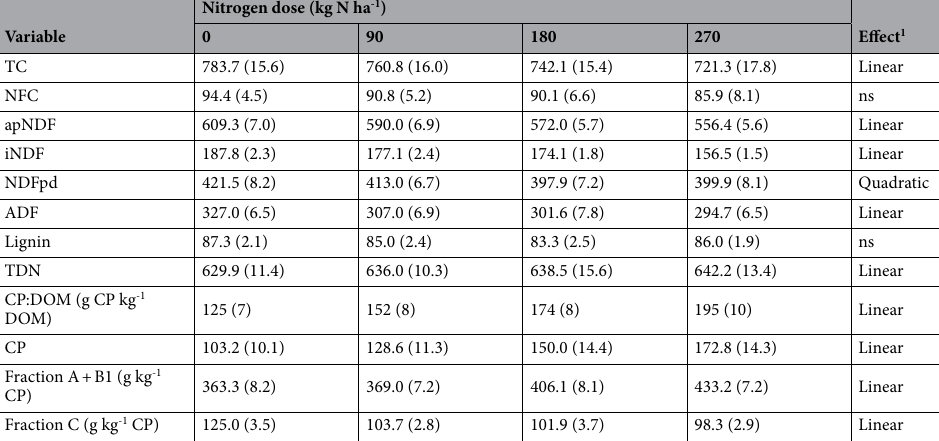
Table 1. Average chemical composition for Marandu palisadegrass (g kg -1 dry matter) affected by nitrogen dose. 1 Orthogonal polynomial effect of N doses. Effect probability (apNDF, P < 0.0001; iNDF, P = 0.046; NDFpd, P = 0.037; ADF, P = 0.05; Lignin, P = 0.19; TDN, P < 0.0001; TC, P < 0.0001; CP:DOM, P < 0.01; CP, P < 0.001; Fraction A + B1, P = 0.006; and Fraction C, P = 0.014). Within parentheses is the standard error of the means (SEM;